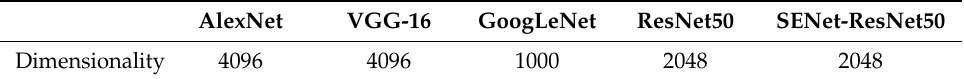
Table 1. Deep feature dimensionality with di ff erent CNN